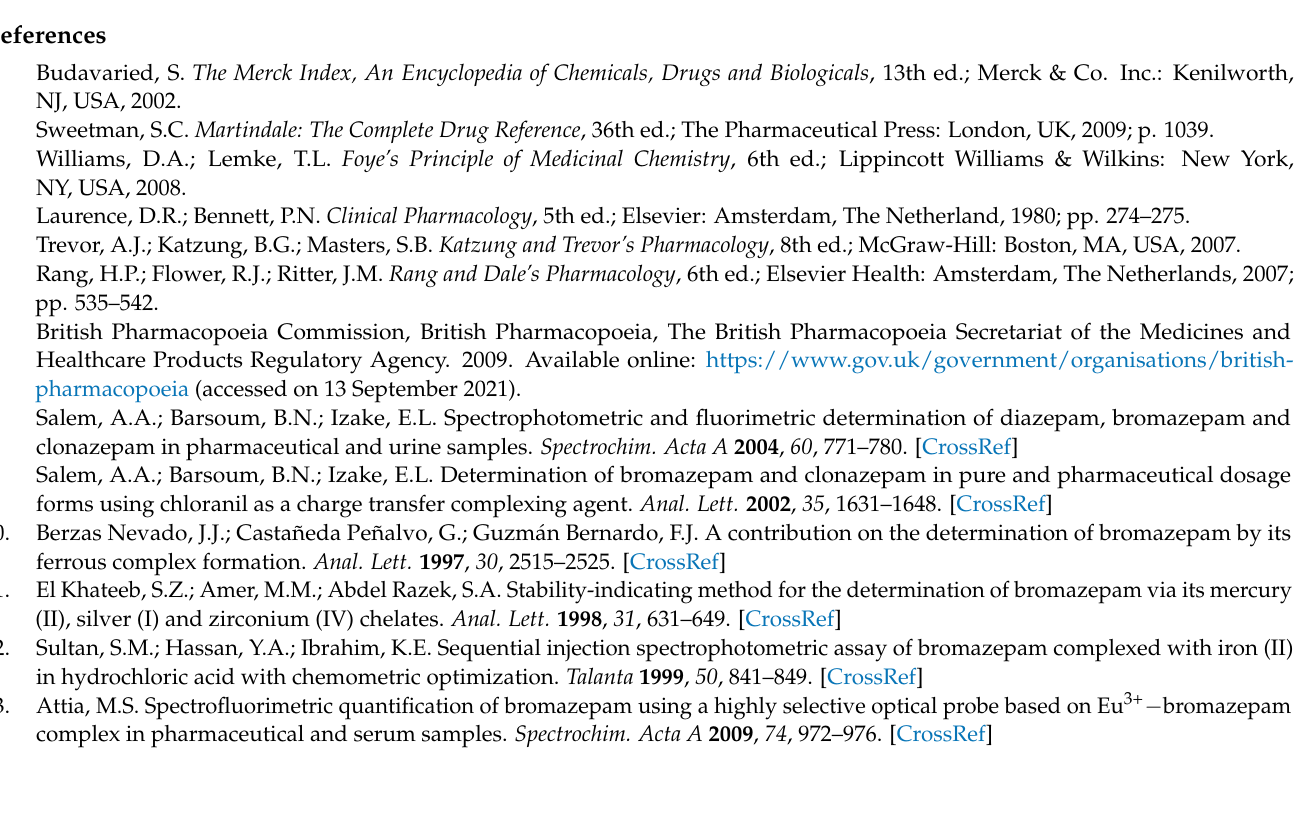
the potential using two concentration levels of BRZ standard solutions; Table S4: Accuracy of the fabricated electrodes; Table S5: Robustness of the fabricated electrodes upon carrying out slight pH change (pH 6.2); Table S6: Ruggedness of the fabricated electrodes using Hanna digital ion analyzer; Figure S1: Calibration graphs for the BRZ electrodes using DOP as plasticizer at 25 ◦ C; Figure S2: Calibration graphs for the BRZ electrodes using DBS as plasticizer at 25 ◦